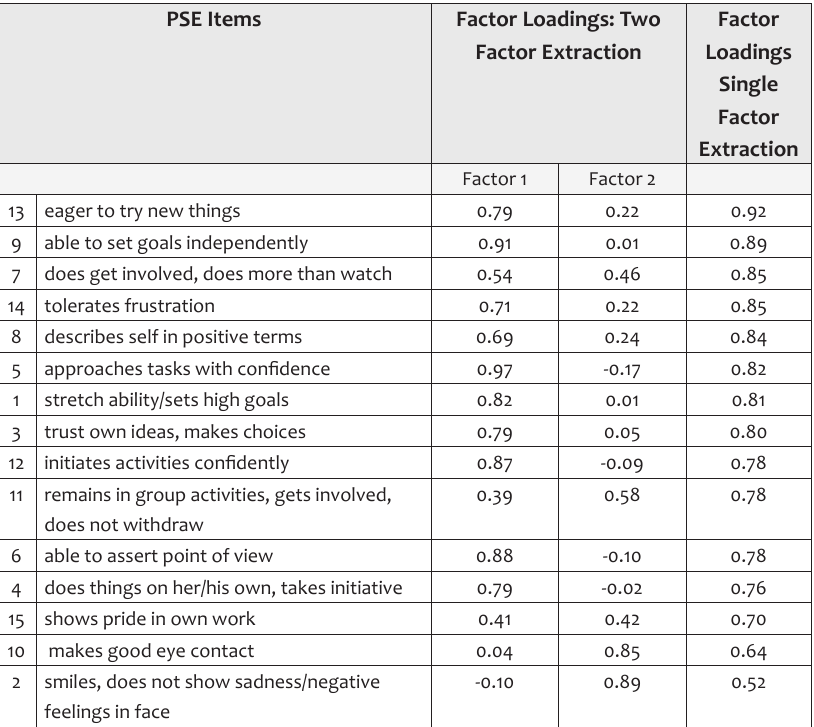
Table 2: Factor Loadings of PSE for Two Factor and Single Factor Solution, Items Sorted Descending for Single Factor